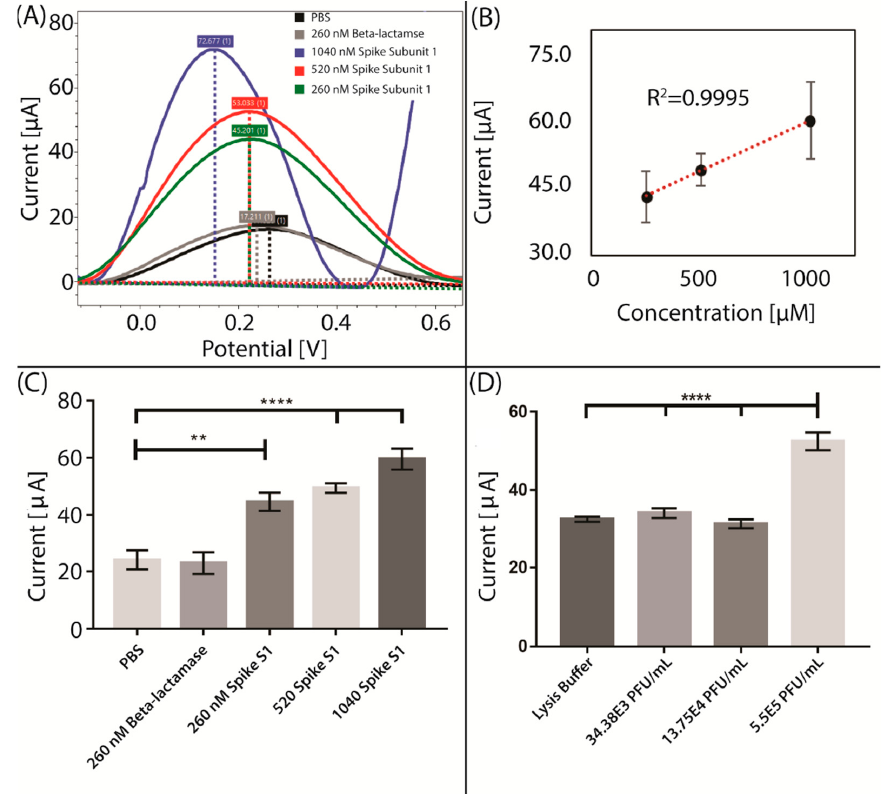
Figure 3. Current perturbation when measuring PBS, beta ‐ lactamase and three different spike concentrations. ( A ) Square wave voltammograms of the signal difference of different spike concentrations and controls. ( B ) Linear regression between spike concentration and current perturbation. ( C ) Extracted peak height averages versus current of tested analytes. Bars are mean values from two separate experiments and batches of sensors with 3 sensors in each; with error bars showing SEM, n = 6. ( D ) Extracted peak height averages of tested analytes versus current when measuring viral lysis buffer and three different recombinant SARS ‐ CoV ‐ 2 virus concentrations. Bars are mean values from 3 separate sensors, with error bars showing SEM, n = 3). Statistical significance was obtained using one ‐ way ANOVA with adjusted p ‐ values of p < 0.01 (**) and p < 0.0001 (****).